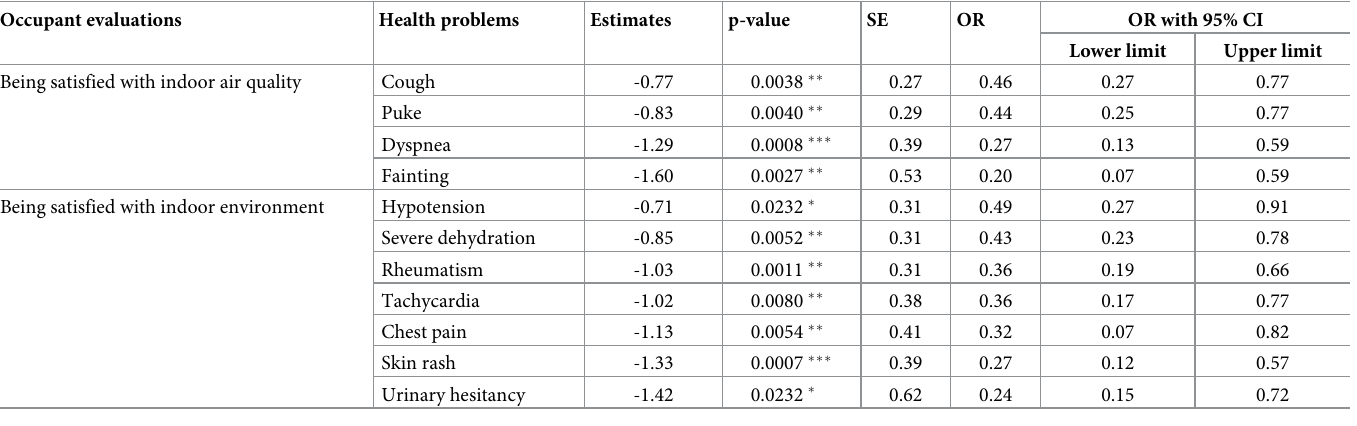
Table 5. Results of logistic regression models and odds ratios along with the 95% confidence intervals (CI) for covariates related to occupants’ indoor environments and air quality satisfaction. Occupant